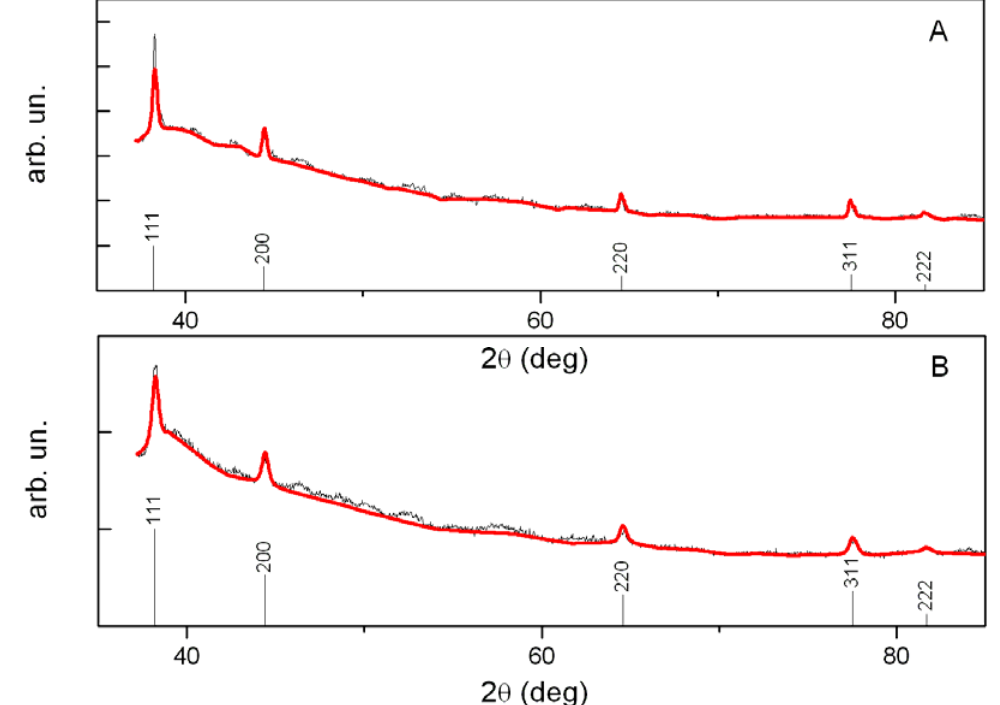
Figure 4. XRD diffractogram of gold clusters embedded in amorphous polystyrene before ( A ); and after ( B ) film dipping in pure acetone (the nanocomposite sample was obtained by isothermally annealing an AuSC H /polystyrene solution for 2 min at 200 °C). 12 25